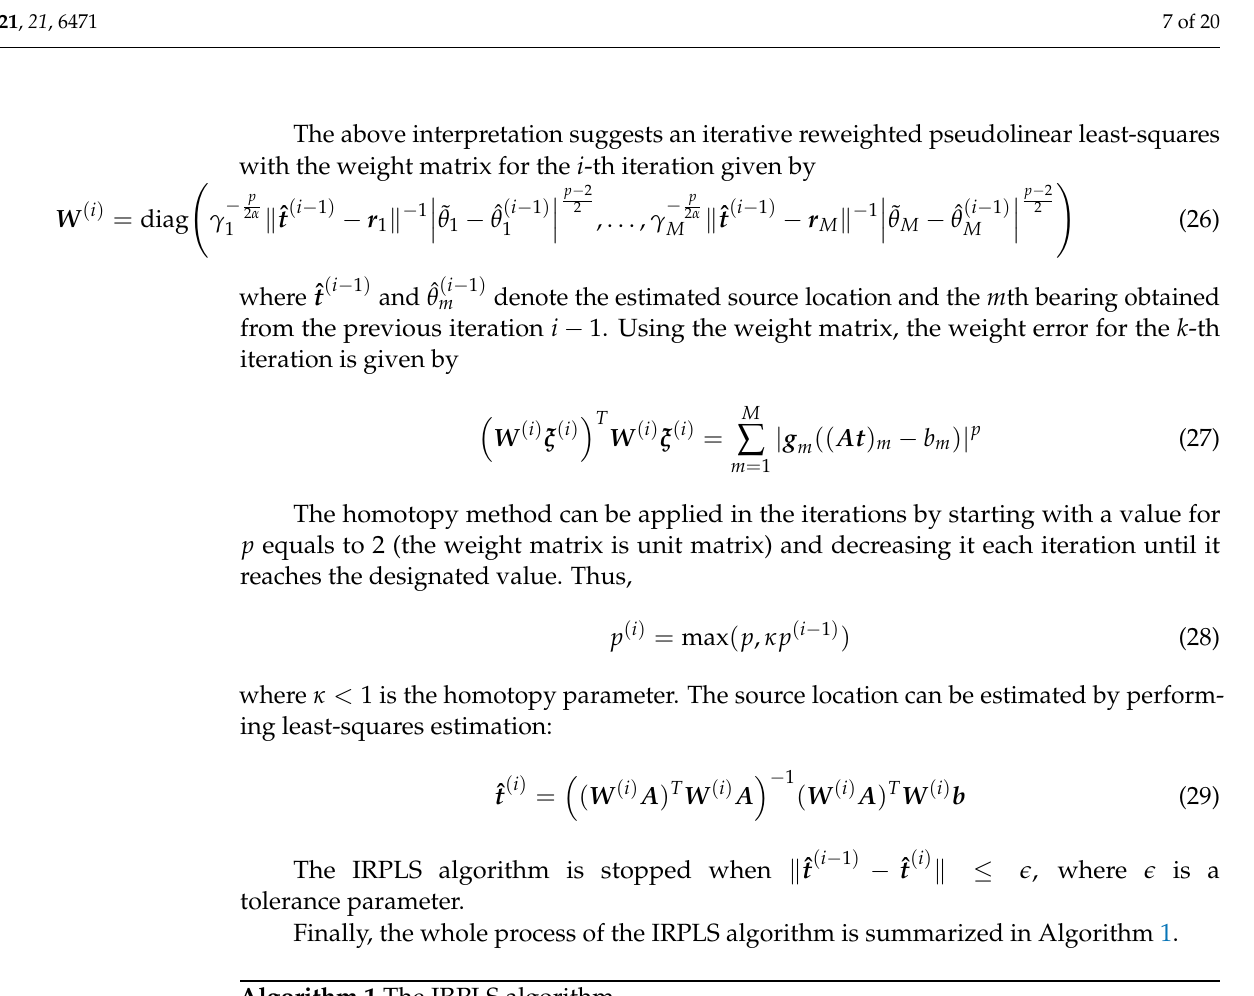
Algorithm 1 The IRPLS